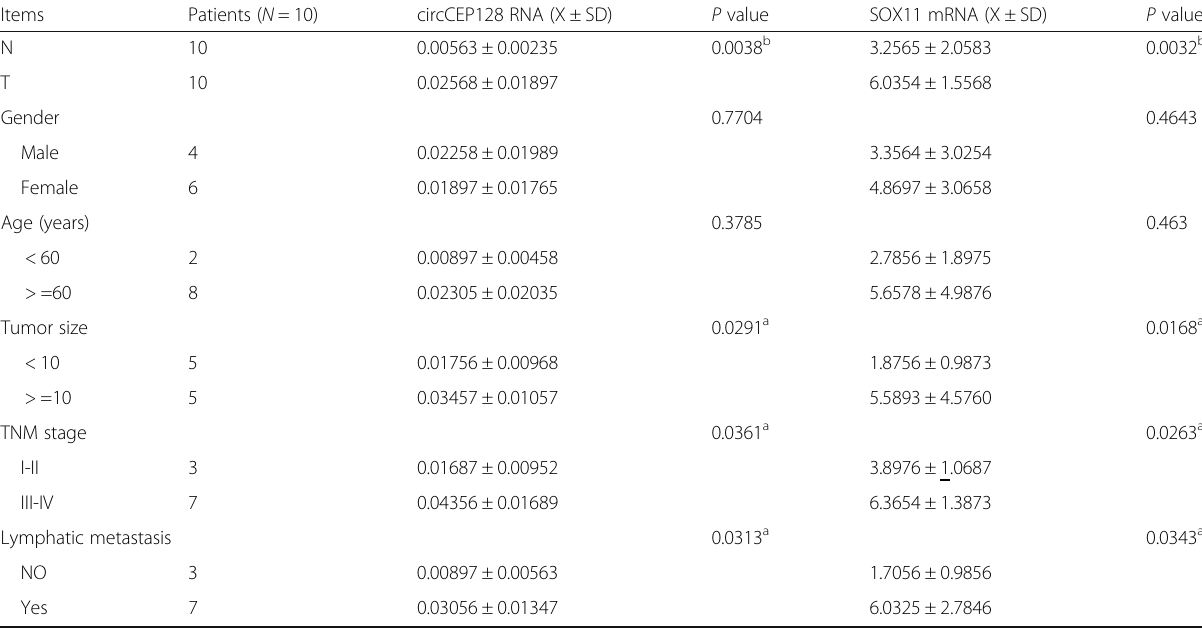
Table 5 The relationship between circCEP128/SOX11 expression and clinicopathological characteristics in bladder cancer patients